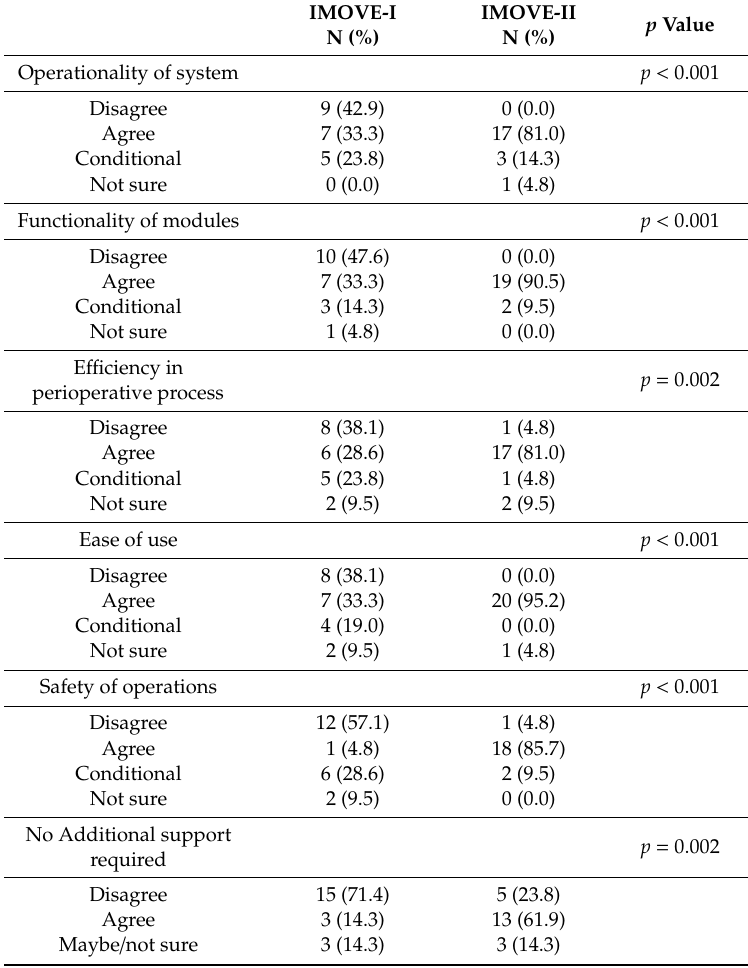
Figure 7. Evaluation of the restraint system by engineers. Table 2. Opinions on system operation, system e ffi ciency, system safety, ease of use of system, functionality of modules and the requirement for additional support. Conditional: subject to conditions or requirements being met to be